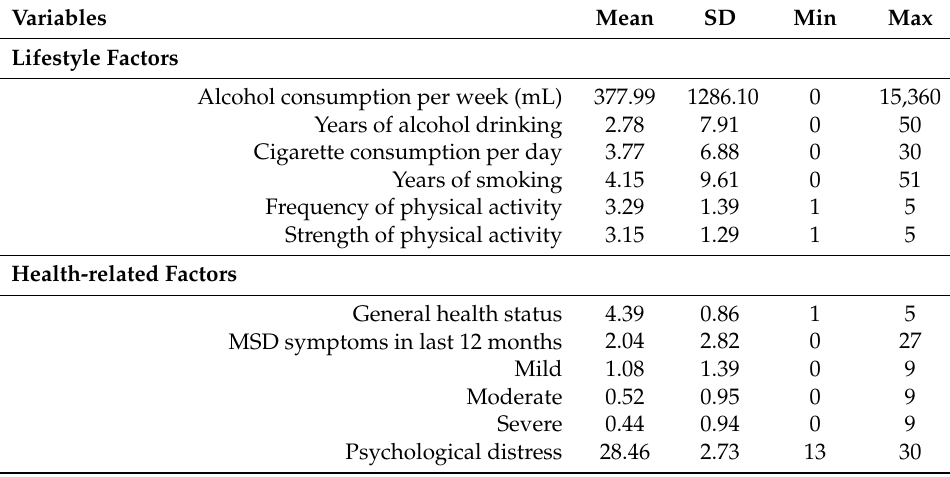
Table 3. Descriptive data for lifestyle factors, health factors, individual competencies, and work-related factors for the 420